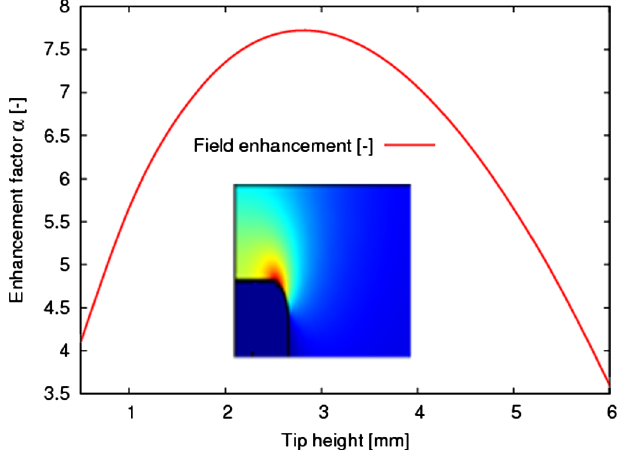
FIG. 9. Simulated macroscopic field-enhancement factor at the center of the Nb 3 Sn (location of laser spot) as a function of tip height above the support. The inset shows the field-enhancement map mimicking a real needle geometry with radius 0.4 mm (only half of the needle cylinder shown), at a tip height of 3 mm. Curvature radius at the edge is 100 (cid:2) m